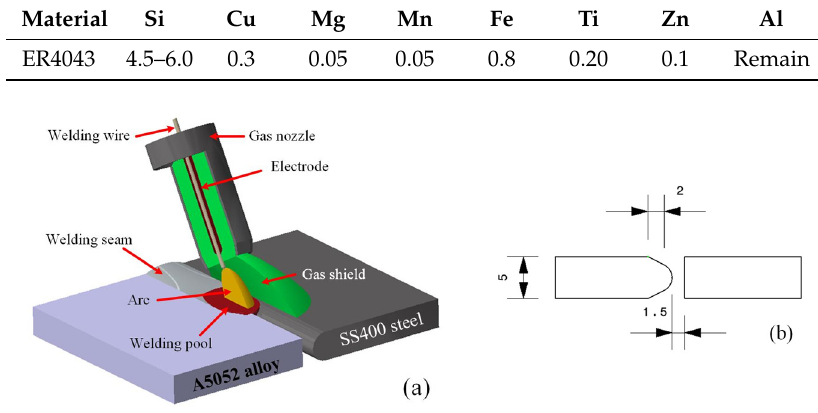
Figure 1. ( a ) Schematic of metal inert gas (MIG) welding process and ( b ) the shape of the new chamfer for A5052 aluminum alloy/SS400 steel.